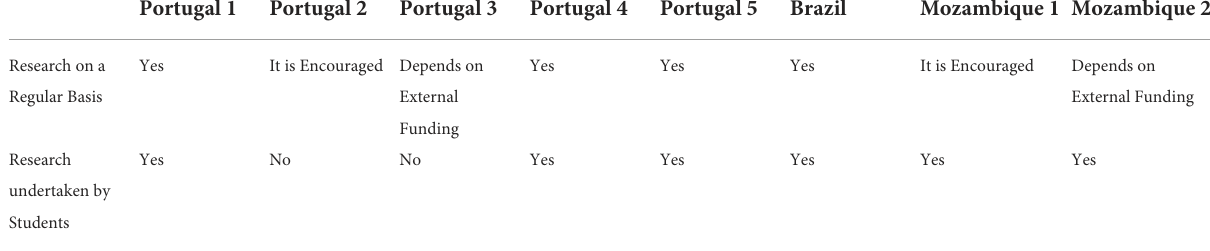
TABLE 4 Research at the department of